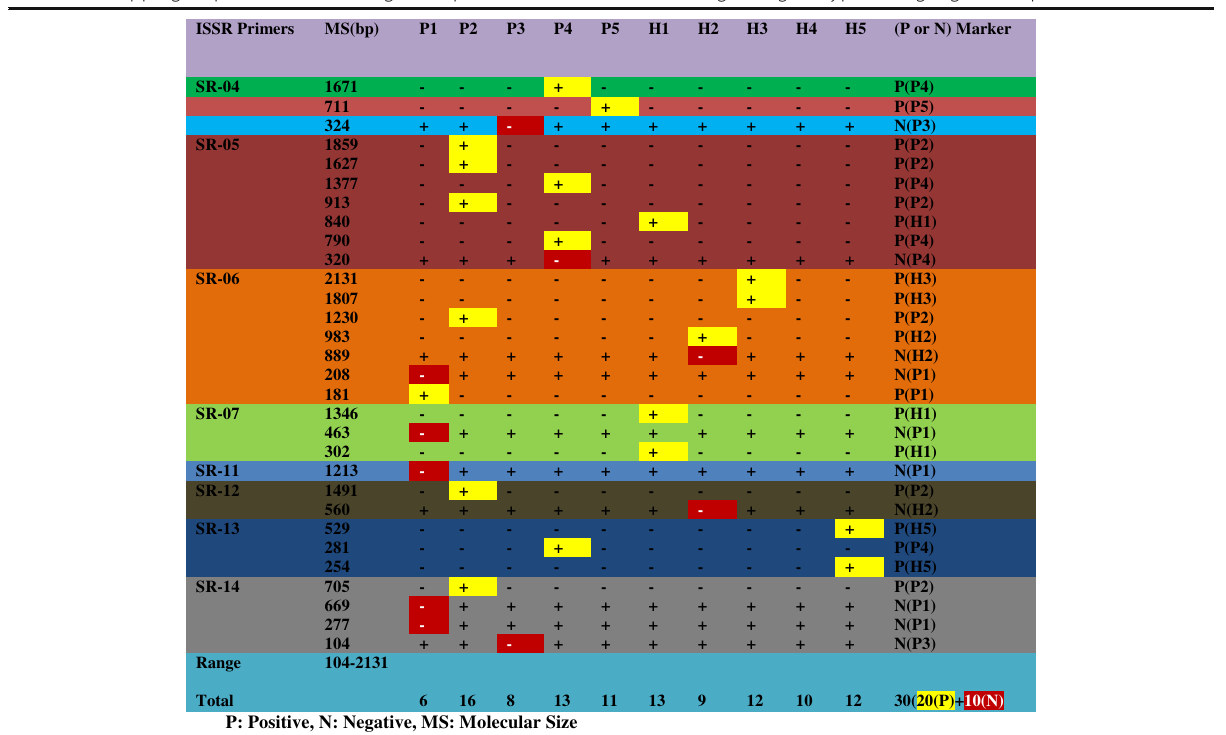
P positive, N negative, MS molecular